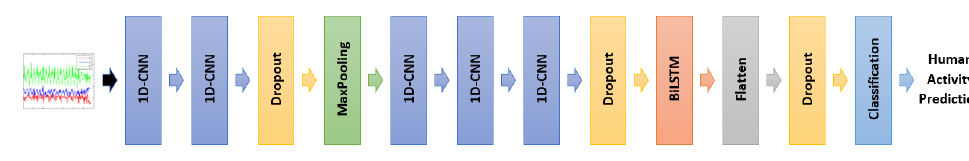
Figure 1. The architecture of the proposed 1D-CNN-BiLSTM model. Table 1. Detailed architecture of